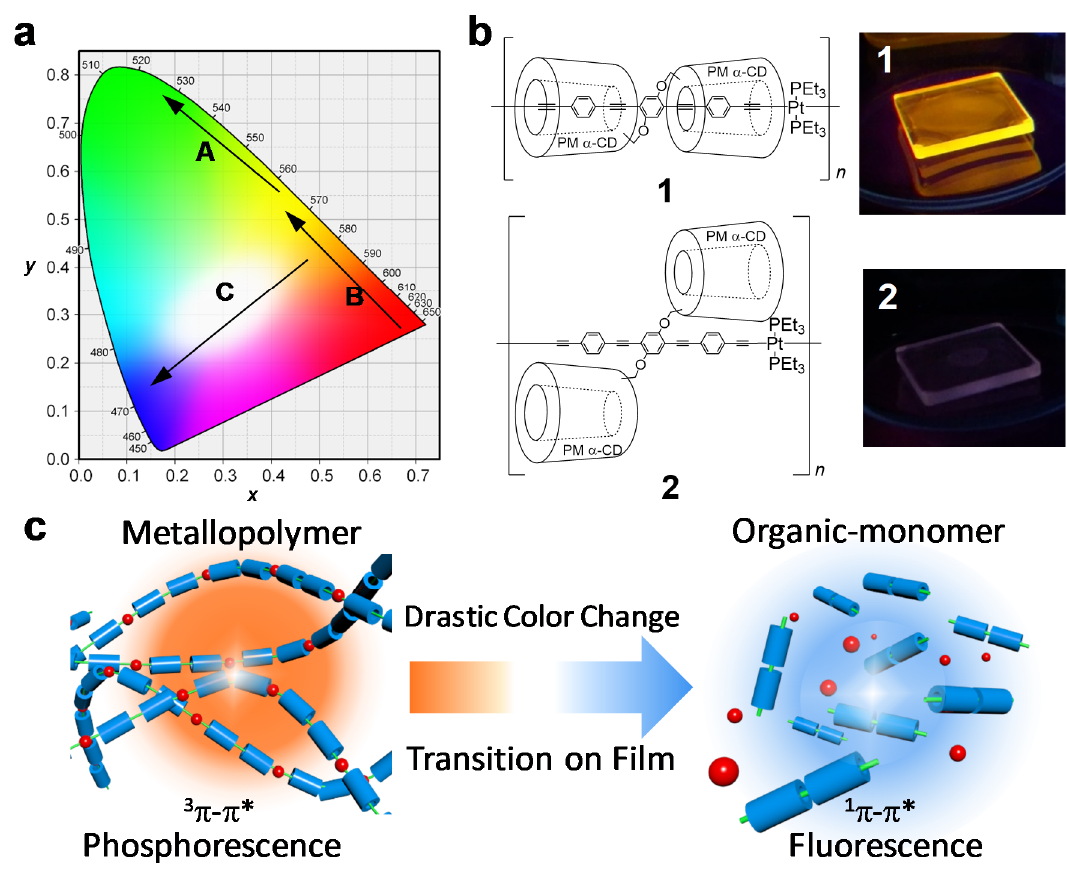
Figure 1. ( a ) Chromaticity diagram with arrows showing the yellow-to-green (A), red-to-yellow (B), and orange-to-white-to-blue (C) shifts. ( b ) Chemical structures and the photographic images (excitation at 365 nm) of emission under deoxygenated conditions for polymer 1 and polymer 2 films on SiO 2 substrates. ( c ) Conceptual illustrations of phosphorescence-to-fluorescence conversion between complementary colors, triggered by metallopolymer to monomer conversion (This study).